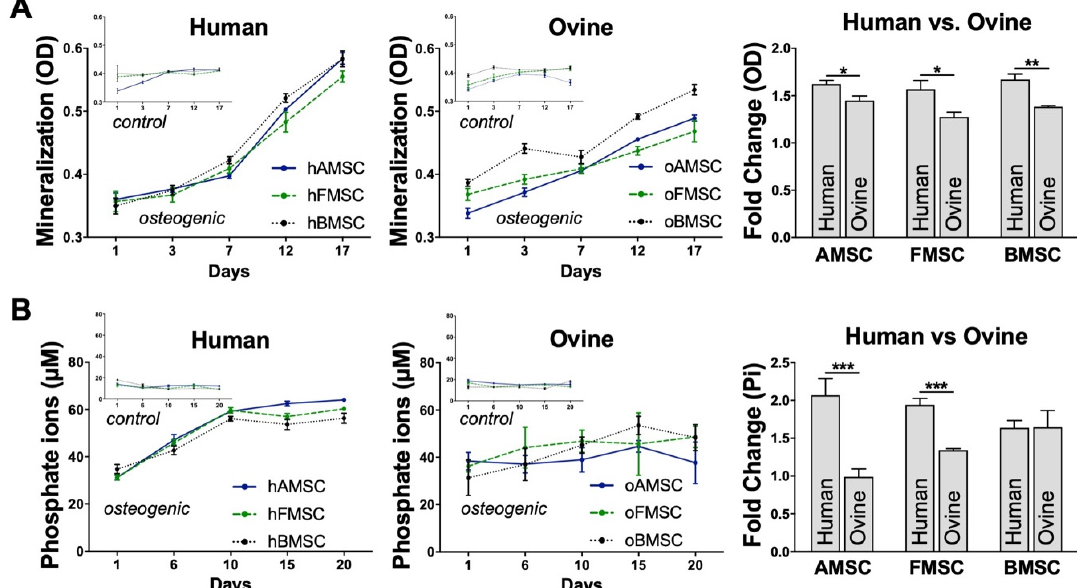
Figure 6. Mineral deposition and phosphate ion release by MSCs from human and ovine sources. MSCs from human and ovine sources were induced towards the osteogenic lineage. Culturing medium without any supplements was used as control. ( A ) The mineral deposition of MSCs from human sources (left) and MSCs from ovine sources (middle) was assessed by optical density (OD) measurement at different time intervals, as indicated. The overall mineralization fold change of MSCs from human and ovine sources was mediated using the ratio d17/d1 (right). ( B ) The osteogenic differentiation process of MSCs from human sources (left) and MSCs from ovine sources (middle) was assessed by measuring the inorganic free phosphate ions (Pi) released into the supernatant at different time intervals. The overall phosphate ion release fold change of MSCs from human sources and MSCs from ovine sources was mediated using the ratio d20/d1 (right). Data are expressed as average ± SEM of 3-6 donors per source. * p < 0.05, ** p < 0.01, *** p < 0.001, Student’s two-tailed unpaired t -test.